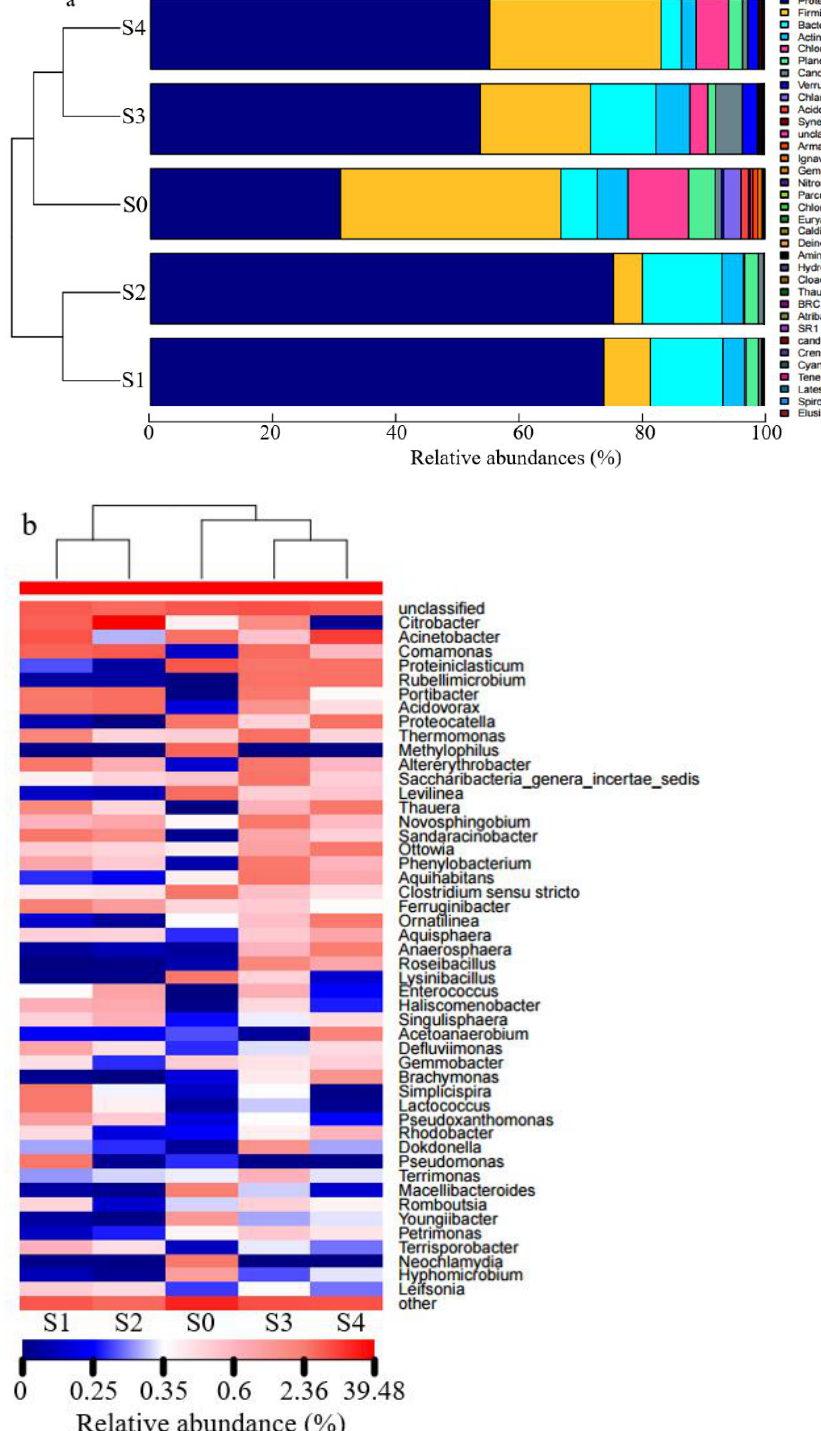
Figure 5. Microbial compositions in sludge samples at phylum ( a ) and genus levels ( b ).